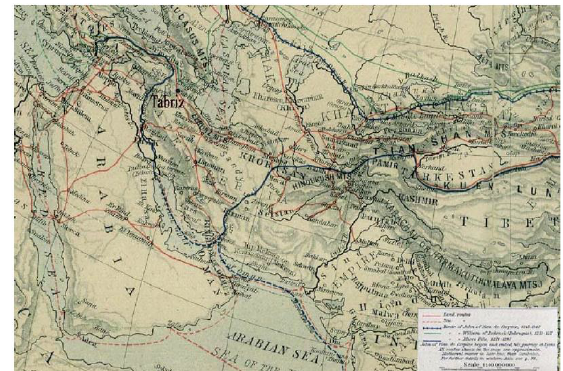
Figure 8. The Map of Iran Plateau’s Folds ( UNESCO, 2009).